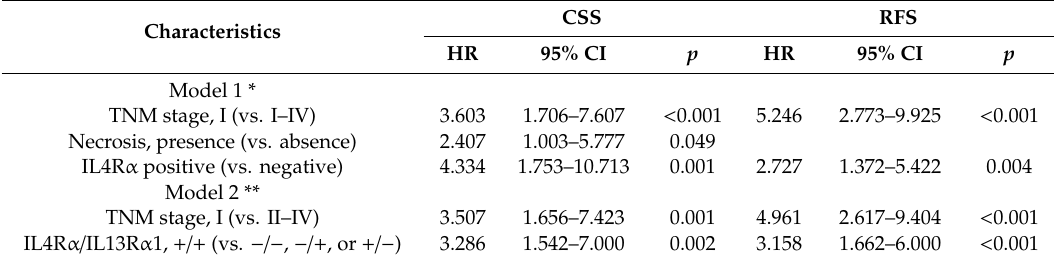
Table 3. Multivariate Cox regression analysis of CSS and RFS in CCRCC